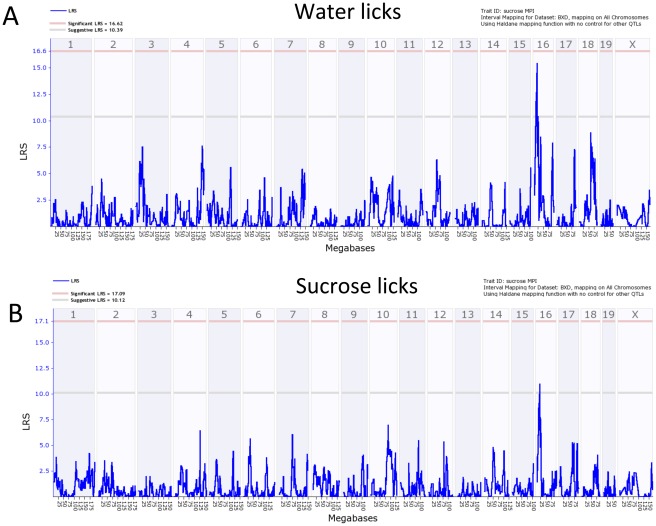
Genome-wide linkage QTL maps of total licks.A. Licks to water. B. Licks to sucrose. A QTL on chromosome 16 exceeds the suggestive threshold (gray line; p<0.63) for either stimulus.